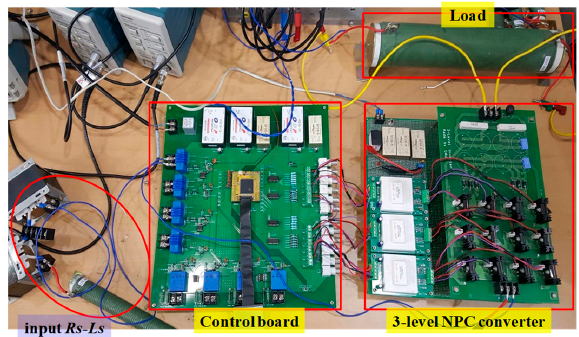
Figure 19. Photograph of prototype setup for single-phase three-level NPC converter.